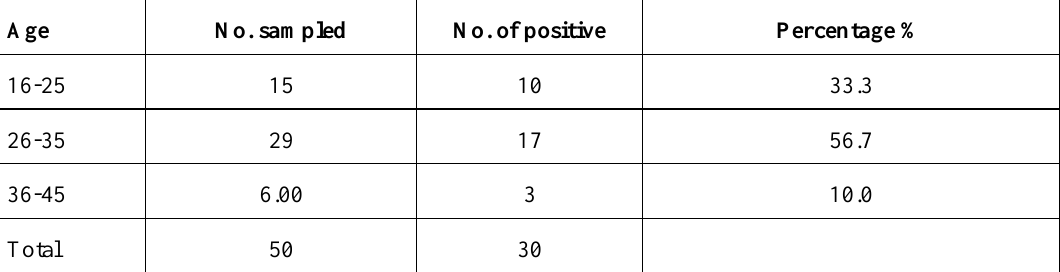
Table 2. Frequency distribution of C. albicans among pregnant women of different ages .